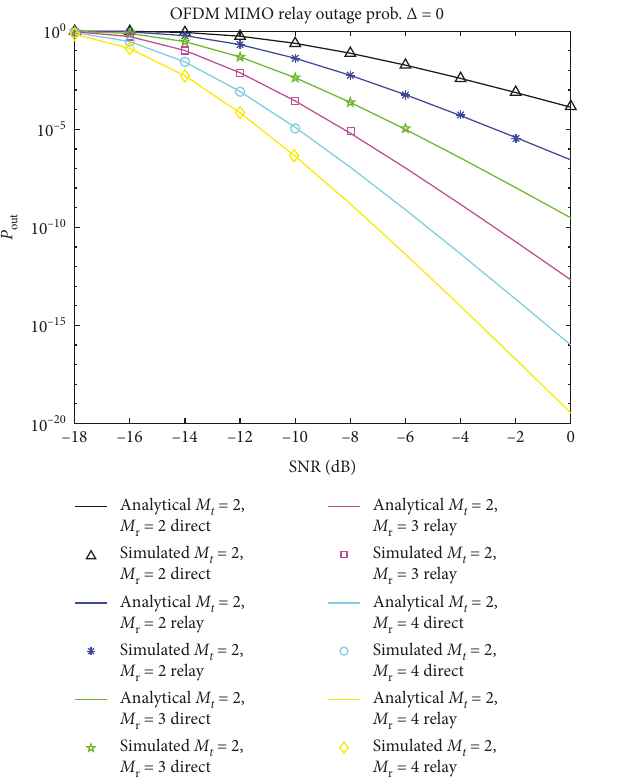
Figure 3: Outage probability with MIMO-OFDM direct and relay ( Δ � 0).